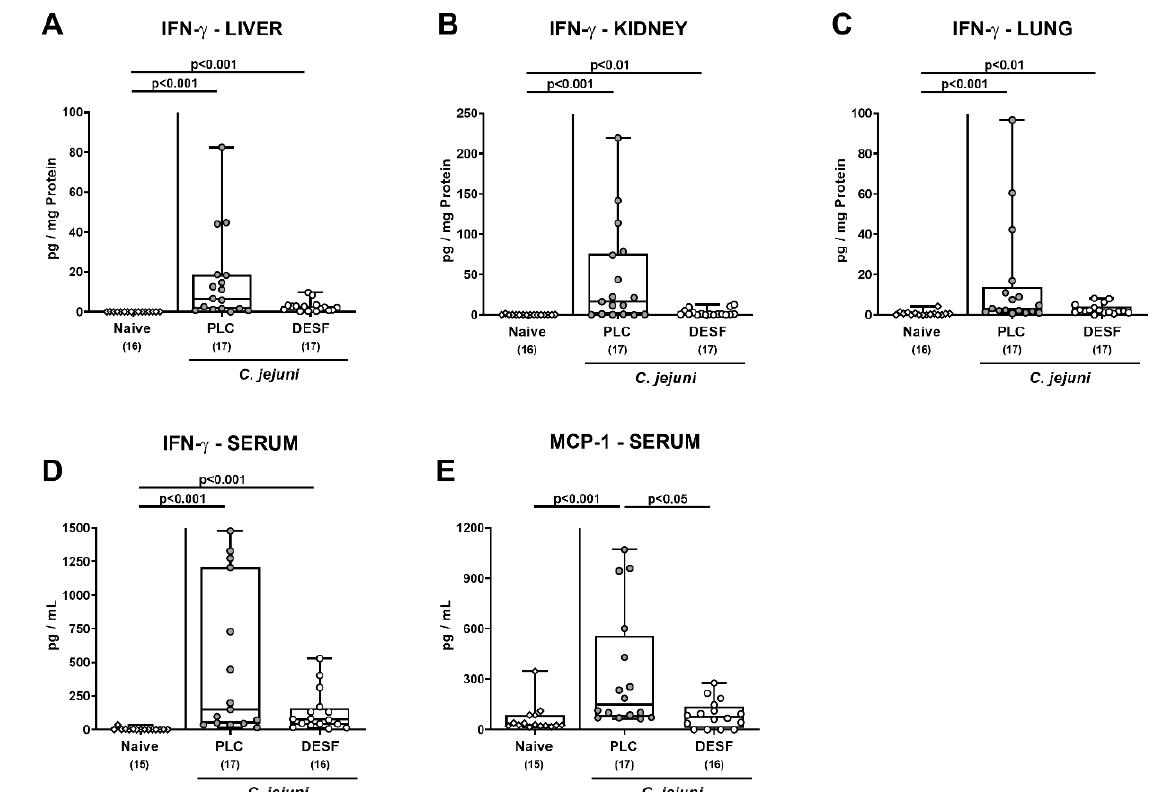
Figure 6. Pro-inflammatory mediator responses following C. jejuni infection of microbiota-depleted IL-10 − / − mice that had been pretreated with deferoxamine. Microbiota-depleted IL-10 − / − mice were subjected to desferoxamine (DESF, white circles) pretreatment via the drinking water starting 7 days prior infection or received autoclaved tap water only (PLC; grey circles). On days 0 and 1, mice were perorally infected with C. jejuni strain 81-176. On day 6 post-infection, IFN- γ concentrations were measured in supernatants taken from overnight cultures of extra-intestinal ex vivo biopsies such as the ( A ) liver, ( B ) kidney, and ( C ) lung and in ( D ) serum samples. In addition, ( E ) MCP-1 secretion was assessed in serum samples. Uninfected and untreated mice served as negative controls (white rhombus). Whiskers indicating the total range, boxes indicating the 25th and 75th percentiles of the medians (black bars inside boxes), significance levels ( p values) calculated by the Kruskal–Wallis test with Dunn’s post-correction, and the total numbers of analyzed mice (in parentheses) are given. Shown data were pooled from three independent experimental sets.